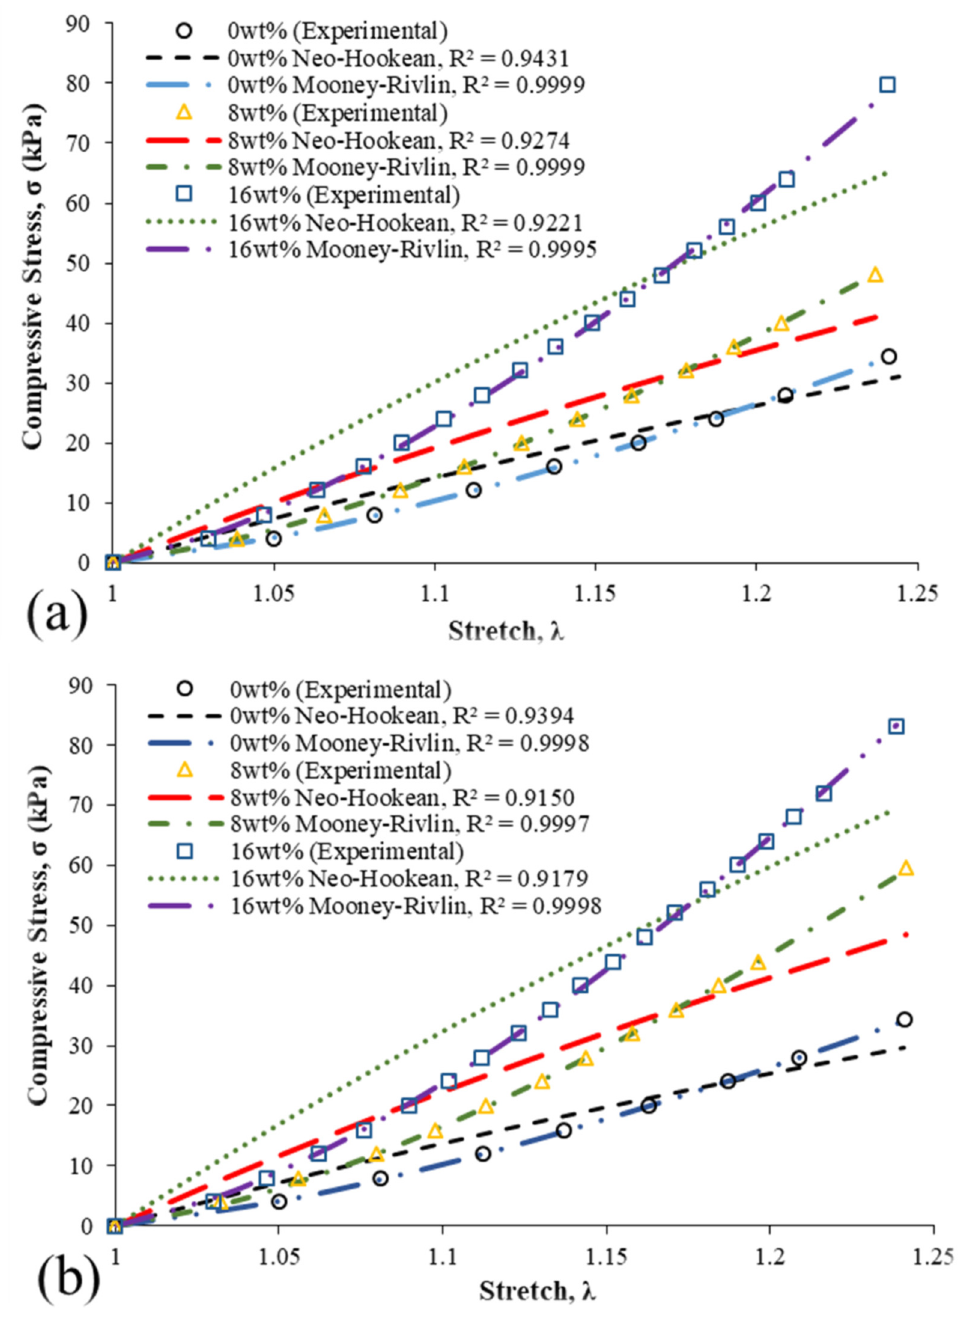
Figure 3. Hyperelastic curve fittings of specimens ( a ) without being immersed and ( b ) immersed in seawater.